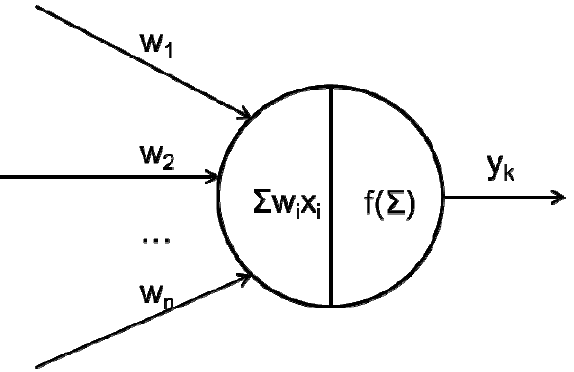
Figure 2. Schematic representation of artificial